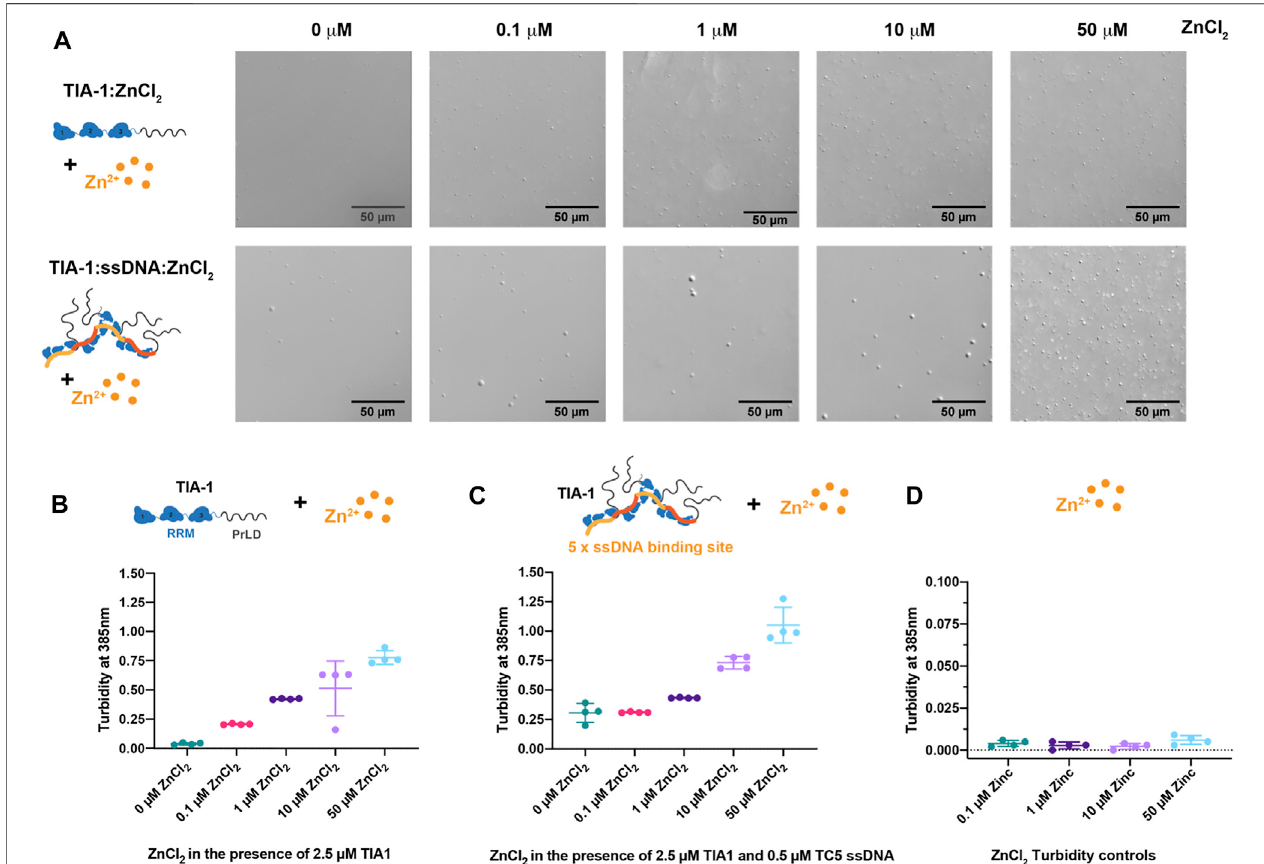
FIGURE1| ZincenhancesLLPSofTIA-1andTIA-1:ssDNAinaconcentrationdependantmanner. (A) DICmicroscopyof2.5 μ MTIA-1(upper)and0.5 μ MssDNA TC5 + 2.5 μ M TIA-1 (lower) in the presence of 0 – 50 μ M ZnCl 2 . (B) Turbidity (A 385 nm ) of 2.5 μ M TIA-1 + 0 – 50 μ M ZnCl 2 . (C) Turbidity of 2.5 μ M TIA-1 + 0.5 μ M ssDNA TC5 + 0 – 50 μ M ZnCl 2 and (D) Turbidity of 0 – 50 μ M ZnCl 2 alone. Conditions: 20 mM HEPES, 50 mM NaCl, 12 mM Arginine, pH 7.2, at 25 ° C and within 20 min of incubation. 4 replicates. Error bars represent S.D.